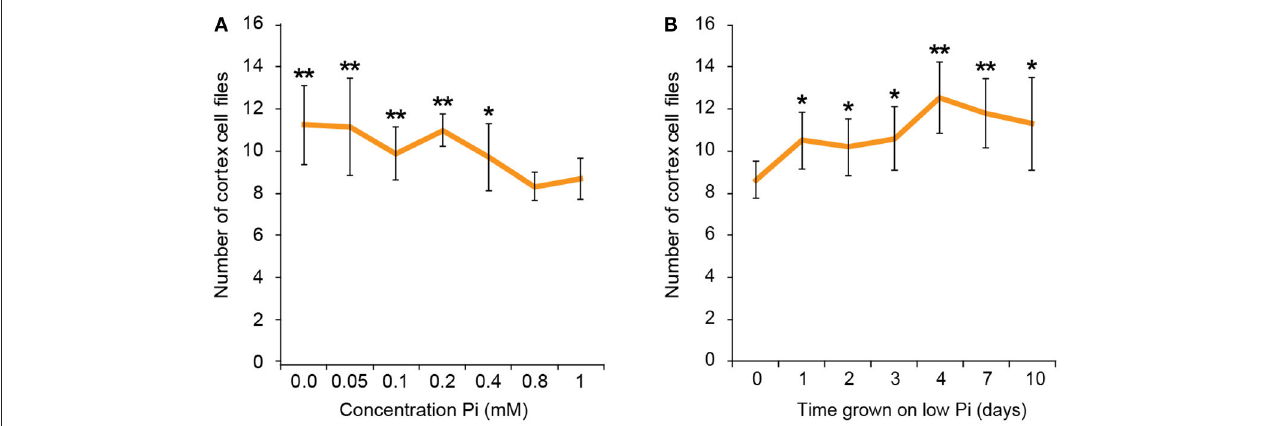
FIGURE 2 | Response to low phosphate is concentration and time dependent. Cortex cell file numbers increase when roots are exposed to medium containing 400 µ M or lower. At lower concentrations the number of cortex cell files is as high as 13, but at 800 µ M − 1mM the number of cortex cell files remains at 8 (A) . Error bars represent standard deviation. Number of plants used in cortex cell file counts 0 M: n = 8; 50 µ M: n = 12; 100 µ M: n = 11; 200 µ M: n = 10; 400 µ M: n = 12; 800 µ M: n = 11; 1 mM: n = 11. **Statistically significant difference to 1mM Pi ( p ≤ 0.005); * p ≤ 0.05 (A) . Cortex cell file number increases to an average of 10 after 24h exposure to low Pi, increasing to an average of 12 after 4 days. (B) Error bars represent standard error. Numbers of plants used in cell file counts 0 days: n = 11; 1 day: n = 10; 2 days: n = 11; 3 days: n = 10; 4 days: n = 9; 7 days: n = 10; 10 days: n = 10. **Statistically significant difference to 1mM Pi ( p ≤ 0.005); * p ≤